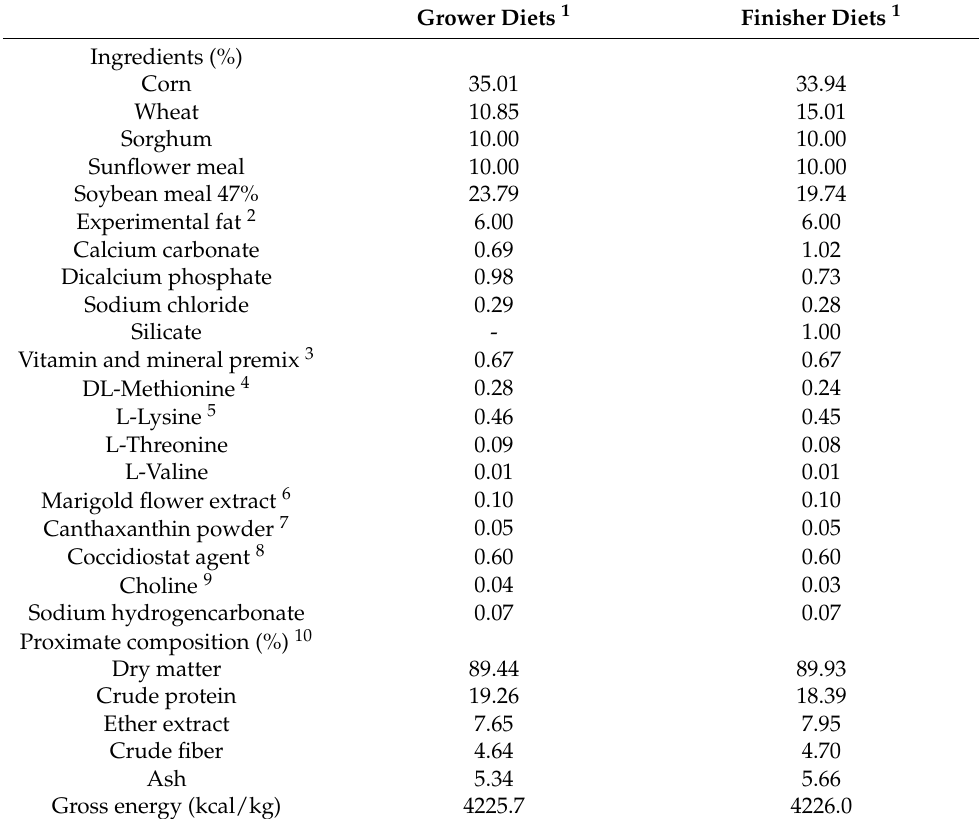
Table 2. Ingredients, proximate composition, and gross energy of the grower and finisher experimen- tal